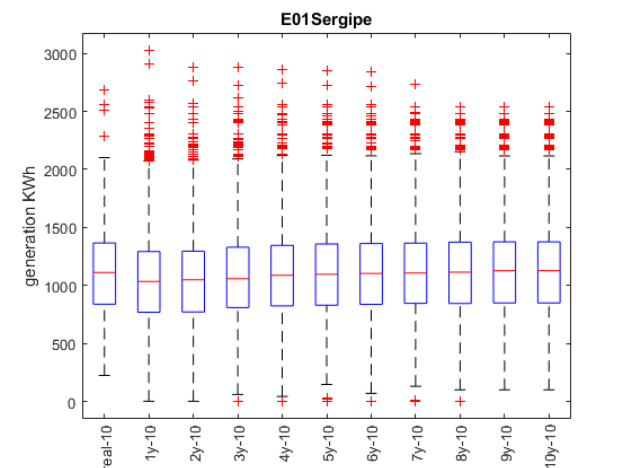
Figure 3. Boxplot years training duration—comparing real generations, and the forecasting